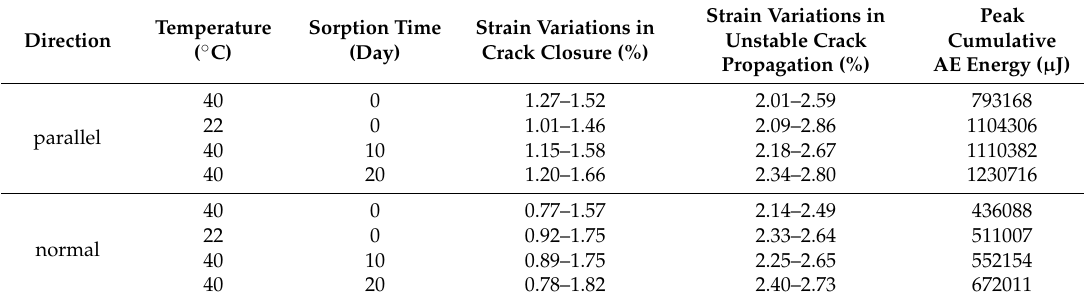
Table 4. The strain distribution and failure mechanism of samples saturated in different conditions. Table 3. The strain and peak energy release of the AE